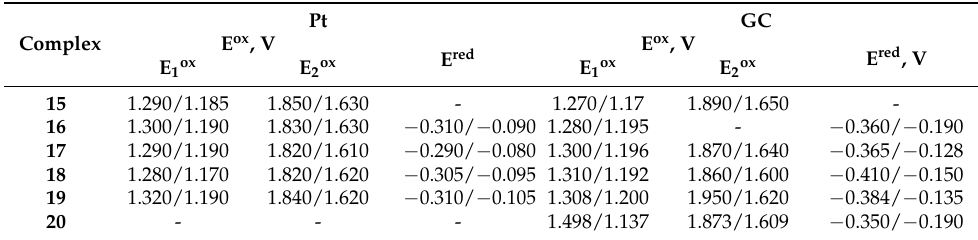
Table 2. Redox potentials of complexes determined with a Pt and the glassy carbon (GC) working